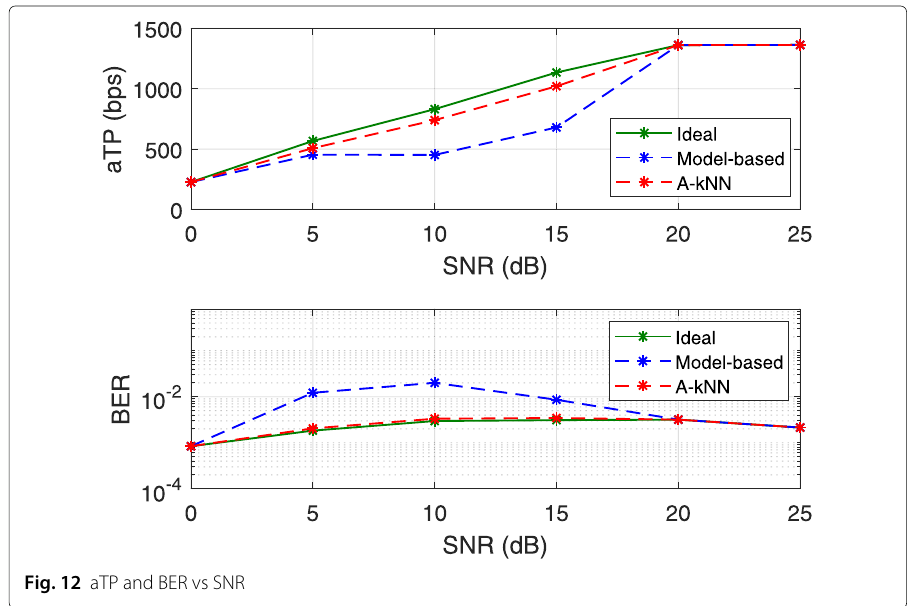
Fig. 12 aTP and BER vs SNR